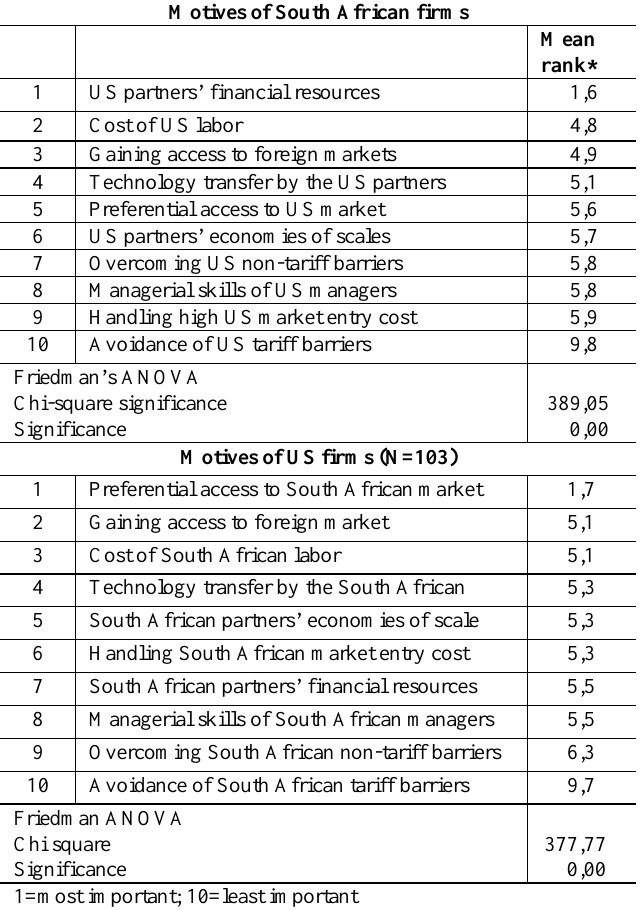
Table 1: Motives for entering South African-US